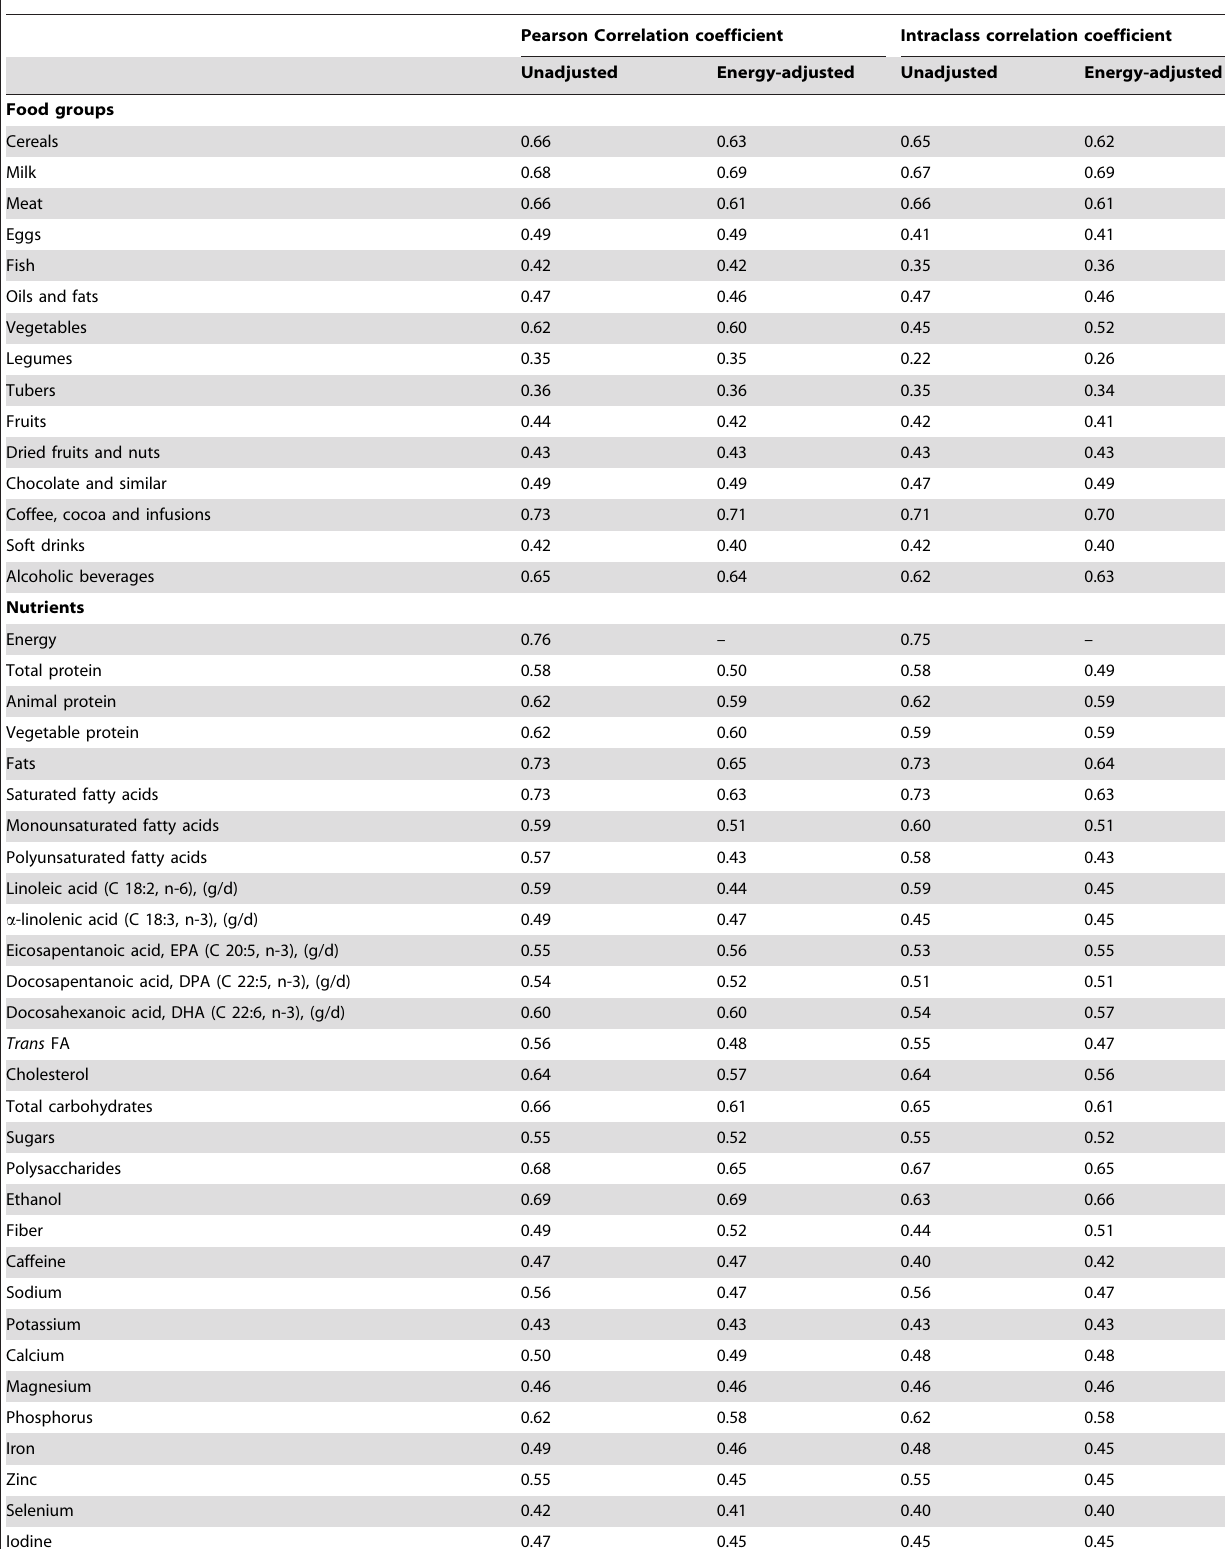
Table 3. Validity of food and nutrient intake estimated by DH-E2 (at 12 months from baseline) versus mean of seven 24-hour recalls during one